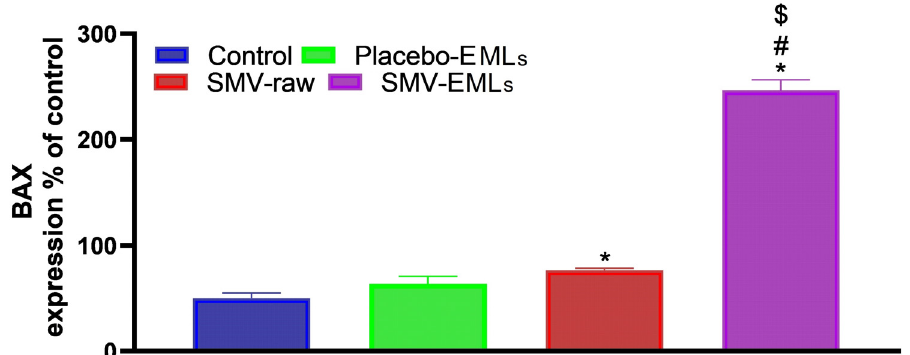
Figure 11. Modulation of Placebo-EMLs, SMV-raw, or SMV-EMLs treatments on Bax protein concentrations in MCF-7 cells. * Significantly different vs. Control ( p < 0.05); # Significantly different vs. Placebo-EMLs ( p < 0.05); $ Significantly different vs. SMV-raw ( p < 0.05).